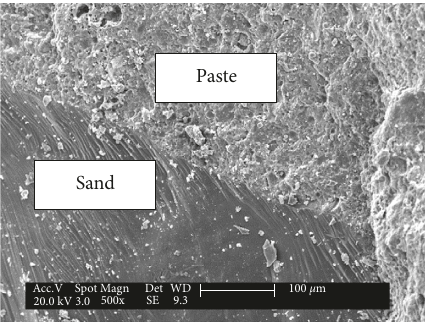
Figure 5: The bond between the sand and paste in plain